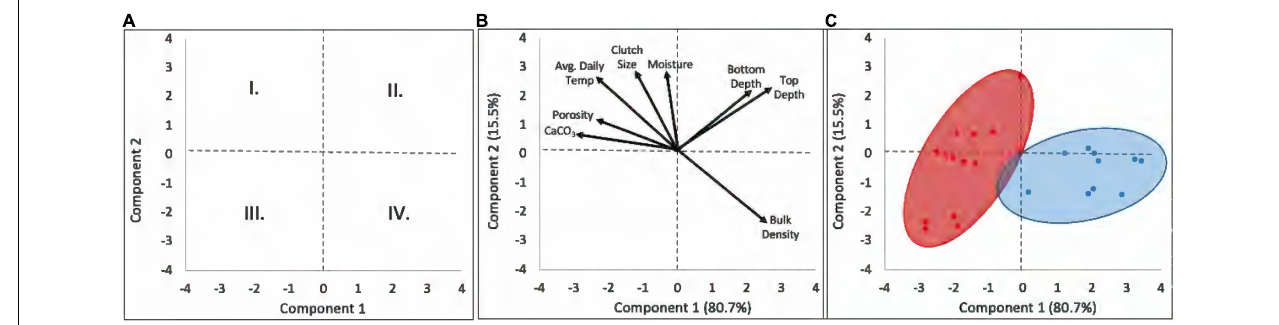
FIGURE 5 | The biplots indicated the spread of successful nest characteristics into four quadrants. (A) Quadrant I represents large clutches, placed in loosely packed, moist sand with high carbonate content, and high clutch temperatures (negative PC1 coefficients and positive PC2 coefficients). Quadrant II represents large clutches, placed deeply, in densely packed sand, low carbonate content, low moisture, and lower clutch temperatures (positive coefficients on PCs 1 and 2). Quadrant III describes small clutches, located shallowly, loosely packed sand, high carbonate content, warm temperatures (negative coefficients on PCs 1 and 2). Quadrant IV represents small clutches, placed shallowly, densely packed sand, low carbonate content, low sand moisture, and lower nest temperatures (positive PC1 coefficients and negative PC2 coefficients). (B,C) Note that the subtropical sites (red) were clustered in quadrants I and III (negative PC1), and the warm-temperate sites (blue) clustered in quadrants II and IV (positive PC1). See text for further